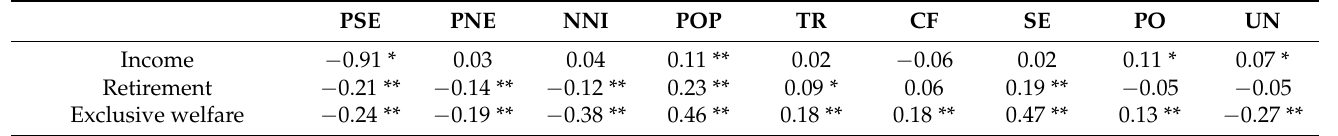
Table 1. Policy support and exclusive well-being: A correlation